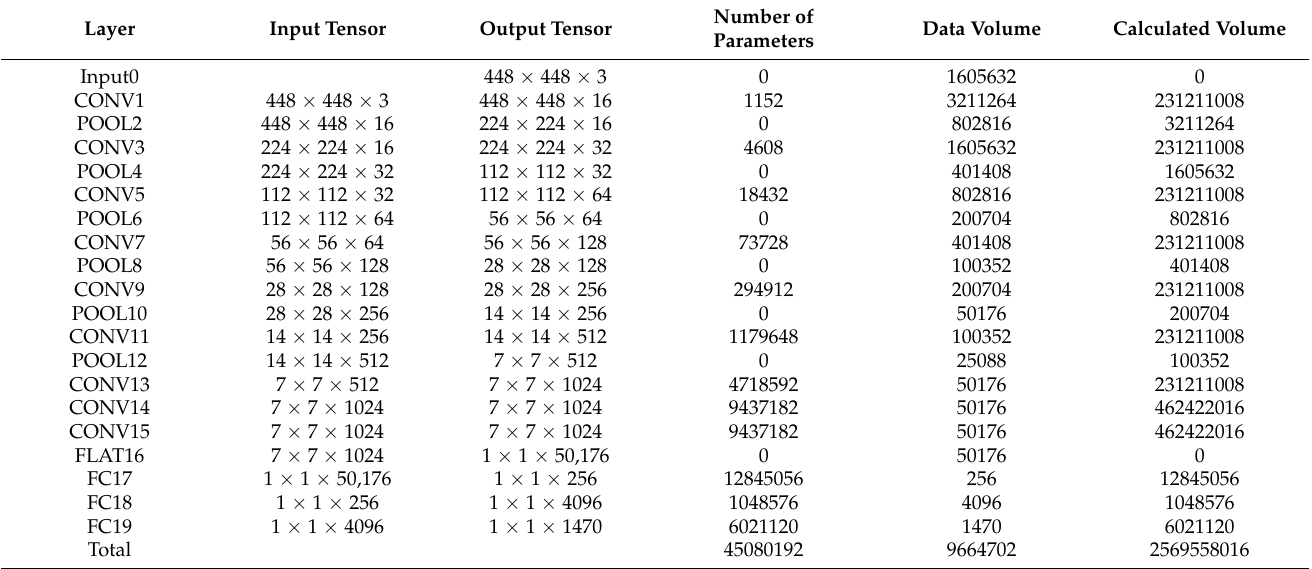
Table 4. TinyYolo parameters for each layer